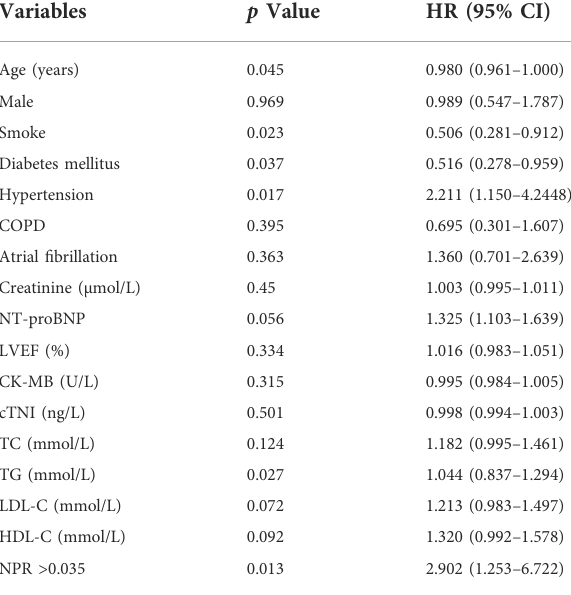
TABLE 2 Cox regression model for all-cause mortality in 3